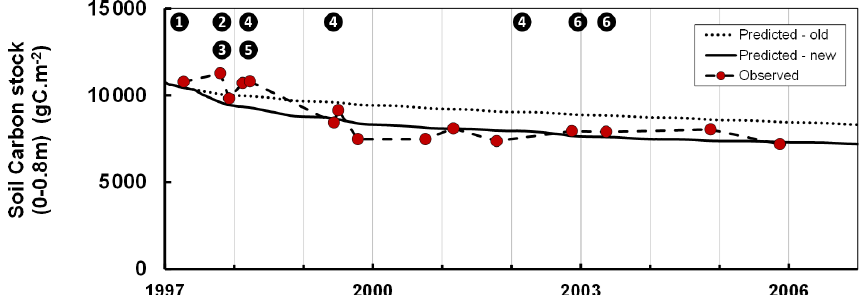
Figure 4. Changes in the soil organic carbon stock during the regeneration phase following a clear-cut of a maritime pine stand as simulated by the GO+ model with and without adaptation for soil preparation (full and dotted lines, respectively) and measured in the field (grey dots). Data taken from Jolivet (2000). The numbers inset in black dots refer to the forest operation. 1: clear-cutting and logging; 2: heavy discing; 3: stump removal; 4: cover crop; 5: tillage; 6: vegetation